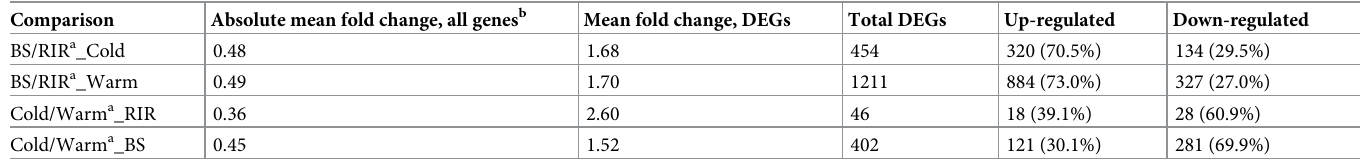
Table 4. Differentially expressed genes.